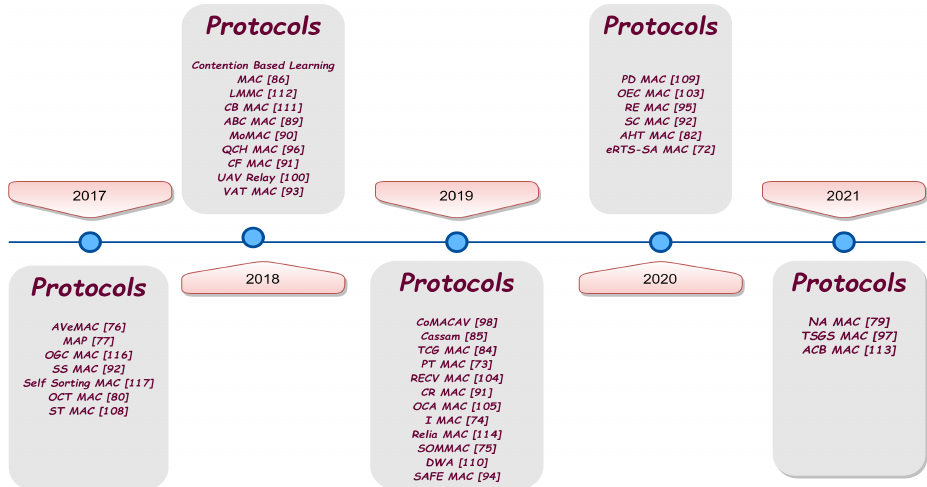
Figure 17. Chronological diagram of MAC protocols